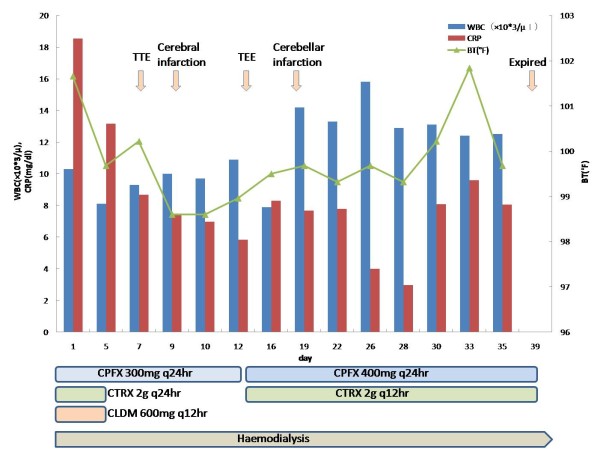
Laboratory data, body temperature, and antibiotics administered to the patient after admission to the hospital. Abbreviations: WBC; white blood cell, BT; body temperature, CRP; C-reactive protein, TTE; transthoracic echocardiography, TEE; transesophageal echocardiography, CPFX; ciprofloxacin, CTRX; ceftriaxone, CLDM; clindamycin